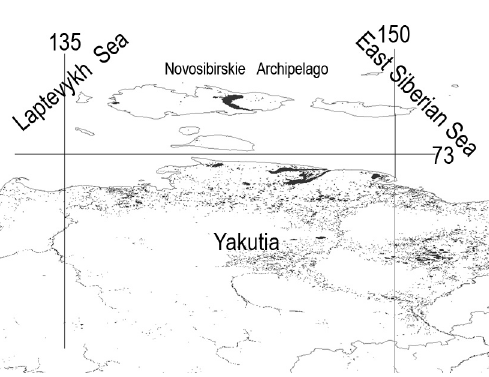
Fig. 17. Map of Novosibirskie Archipelago calving